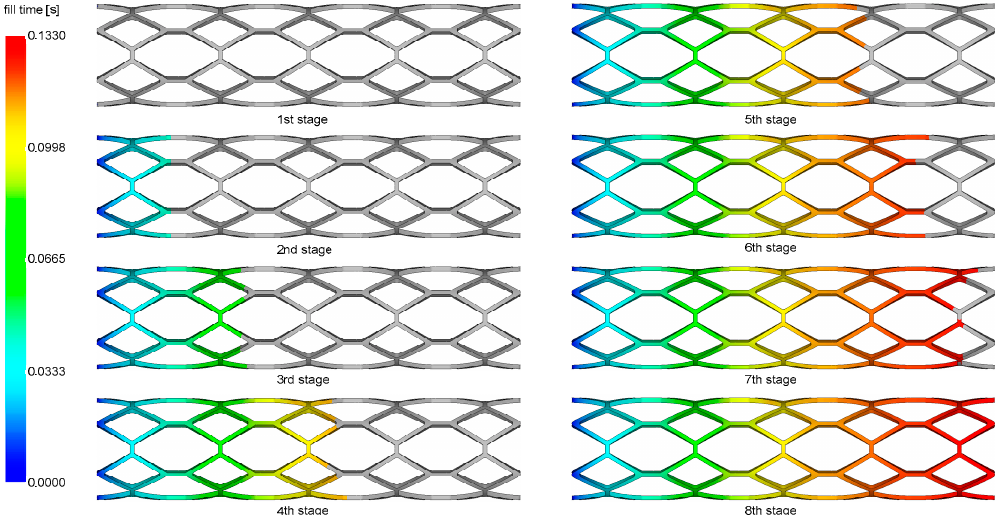
Figure 5. The injection molding process of a stent.